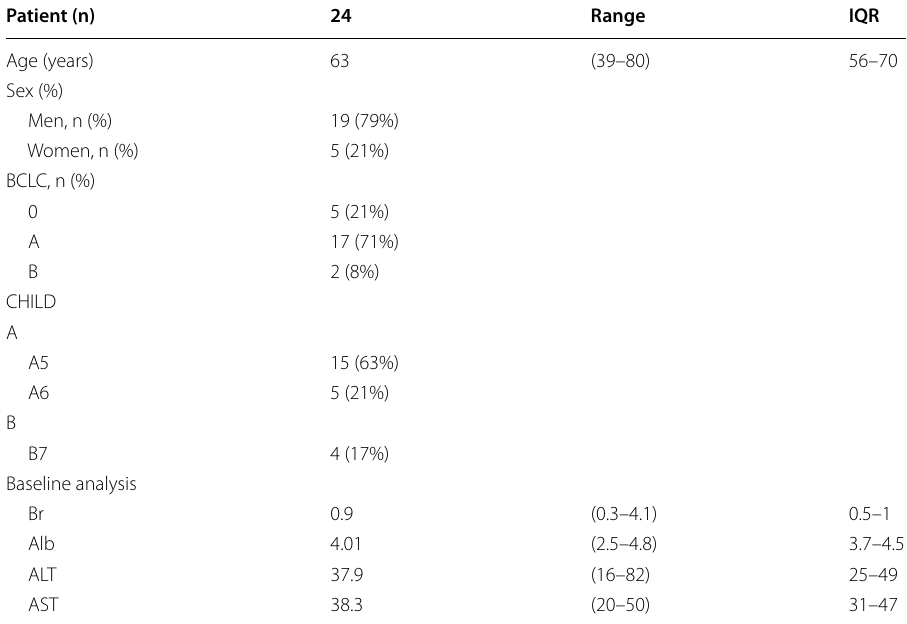
Table 1 Patients